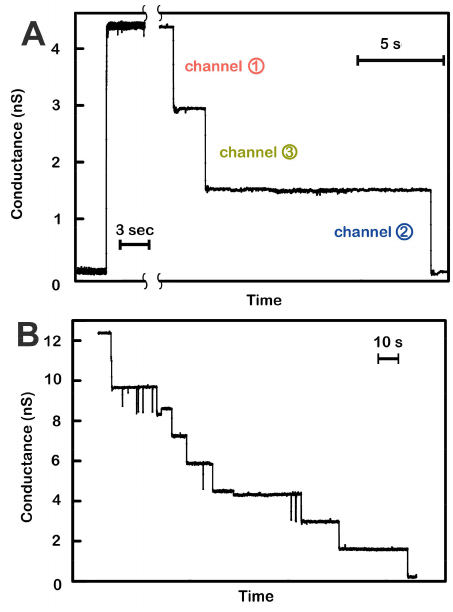
Figure 1. Voltage-dependent channel closure of triplins inserted into planar phospholipid membranes. ( A ) Insertion of a single triplin into a planar phospholipid membrane. The single insertion event (left) took place under a + 10 mV applied potential. When the potential was raised to + 70 mV,